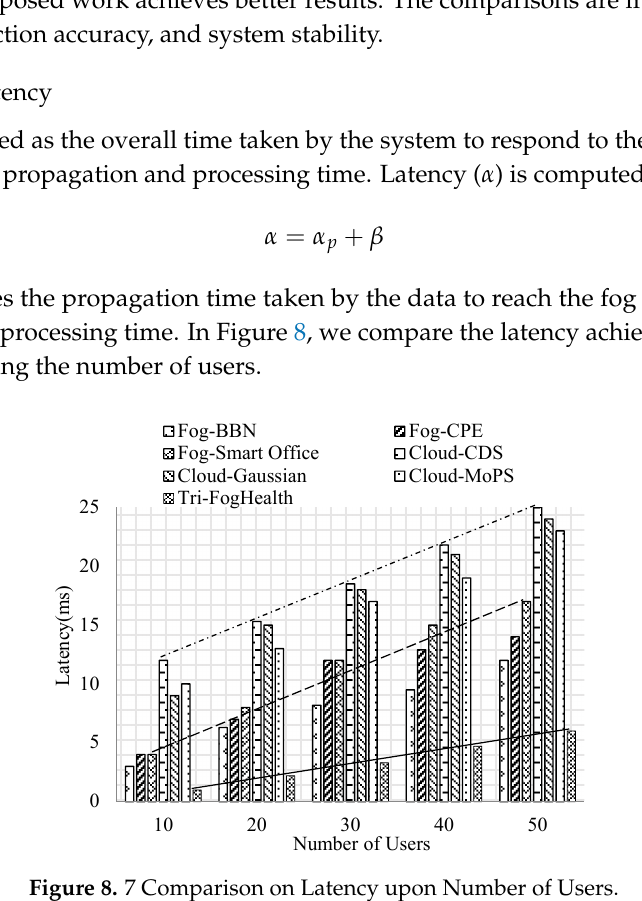
Figure 8. 7 Comparison on Latency upon Number of Users.